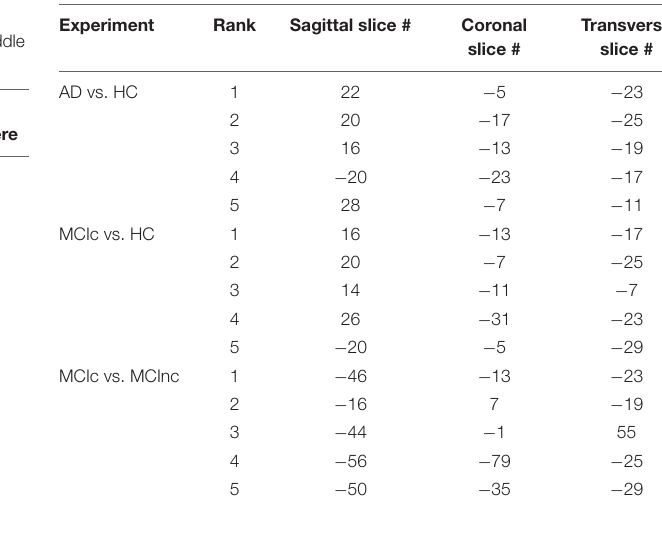
TABLE 7 | Sagittal, coronal, and transverse slice numbers corresponding to the 15 best base classifiers for the first time to run the stratified fivefold cross-validation